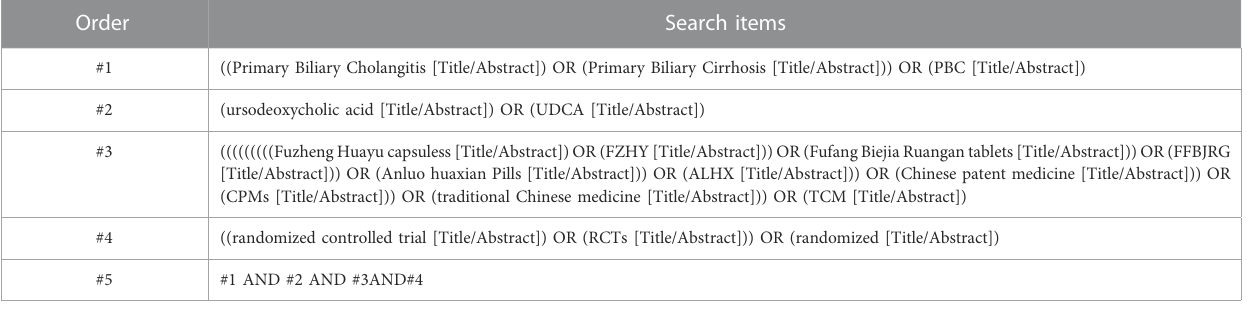
TABLE 1 The search strategy.